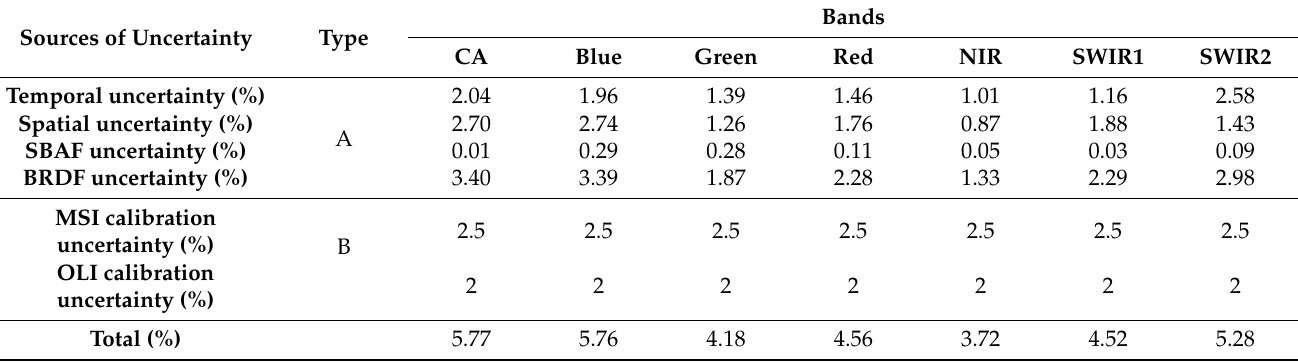
Table 2. Sources of uncertainty for the cross-calibration of Landsat 8 and Sentinel